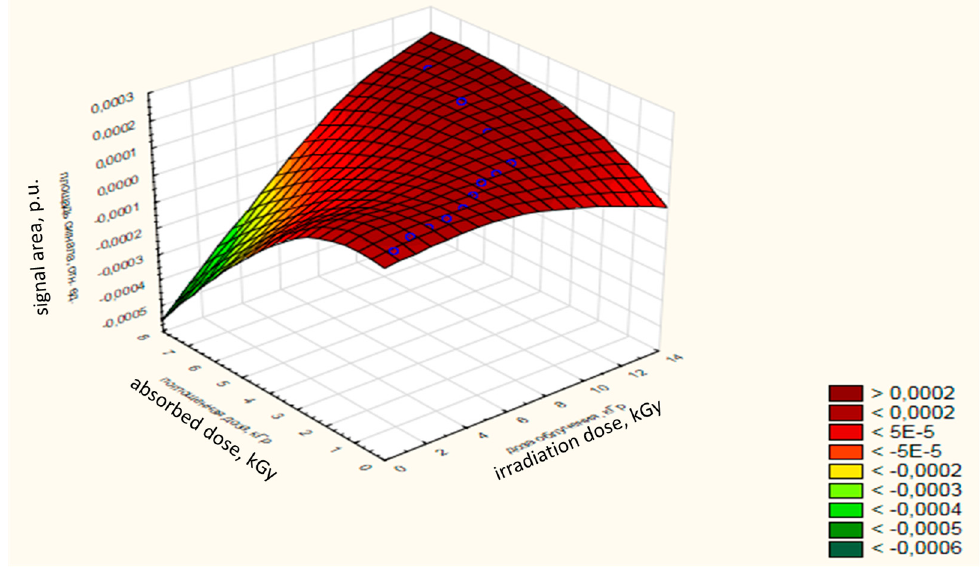
Figure 5. Dependence of change in the absorbed dose (Y) and irradiation dose (X 1) , as well as signal area (X 2 ) for OCT.